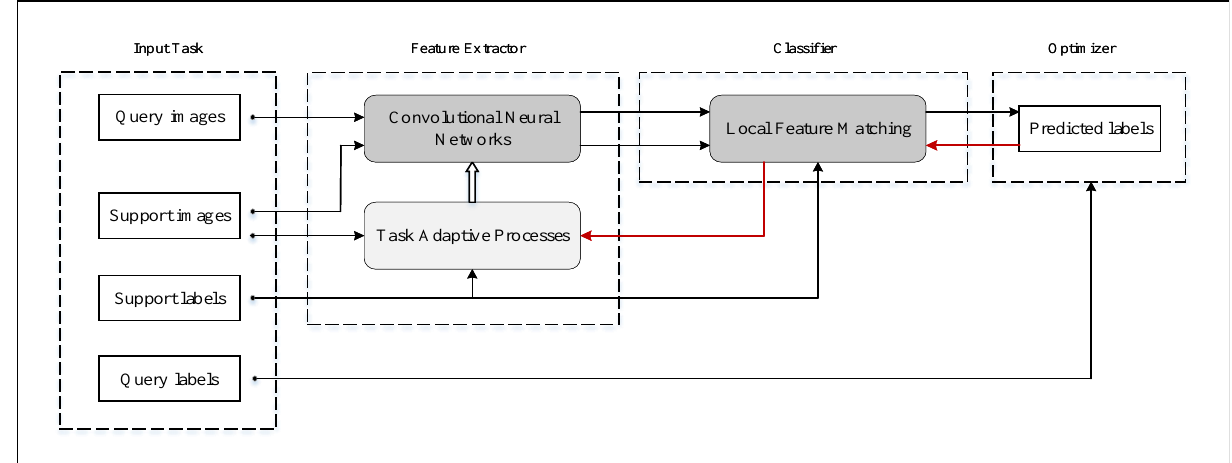
Figure 1. Flow chart of LFM-CNAPS. In the figure, the white solid squares are data variable, the black arrows are the data flow direction, the white hollow arrows are forward propagation, and the red arrows are backward